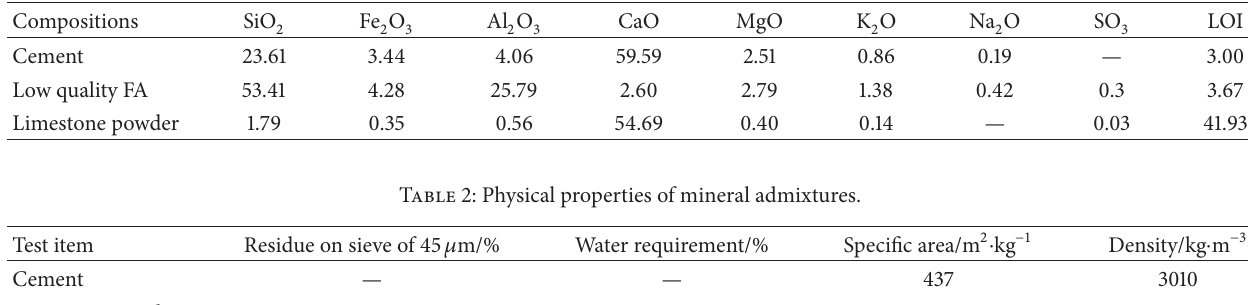
Table 1: Chemical composition of cement, low quality fly ash, and limestone powder/mass, %.